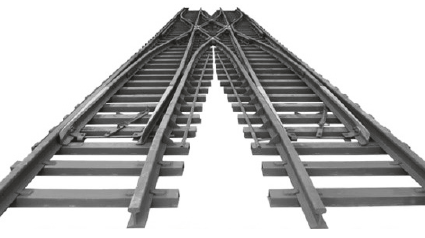
Figure 1: Turnout